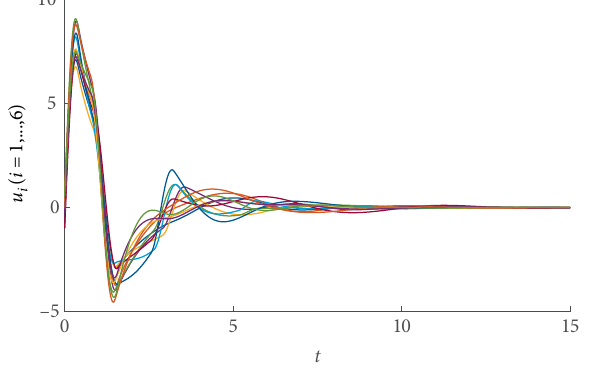
of a six-agent. 𝑖